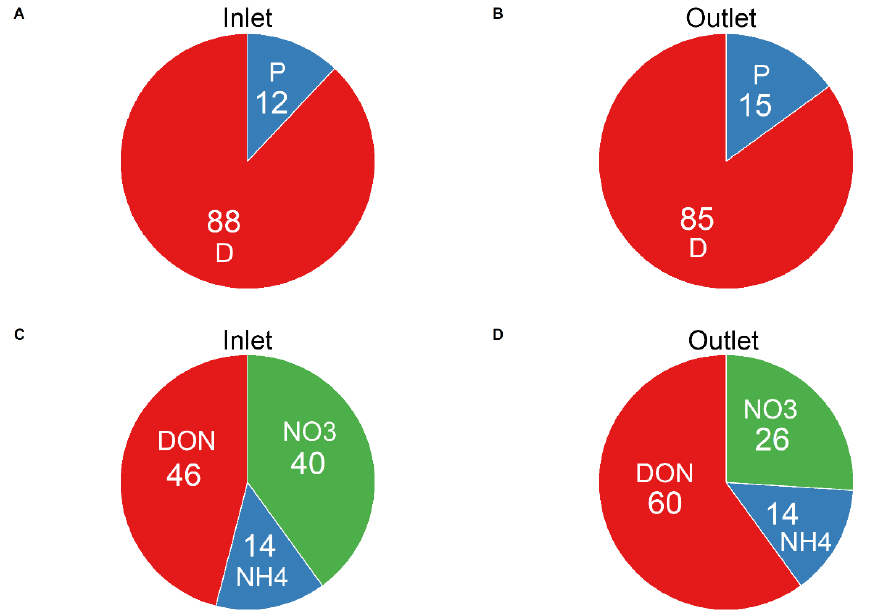
Figure 8. Speciation of nitrogen including percentage of total nitrogen in dry basin inflow ( A ) and outflow ( B ) that was particulate (P) and dissolved (D) nitrogen. The percentage of dissolved nitrogen for inflow ( C ) and outflow ( D ) that was organic (DON), nitrate (NO 3 − ), and ammonium (NH 4+ ) is also shown.